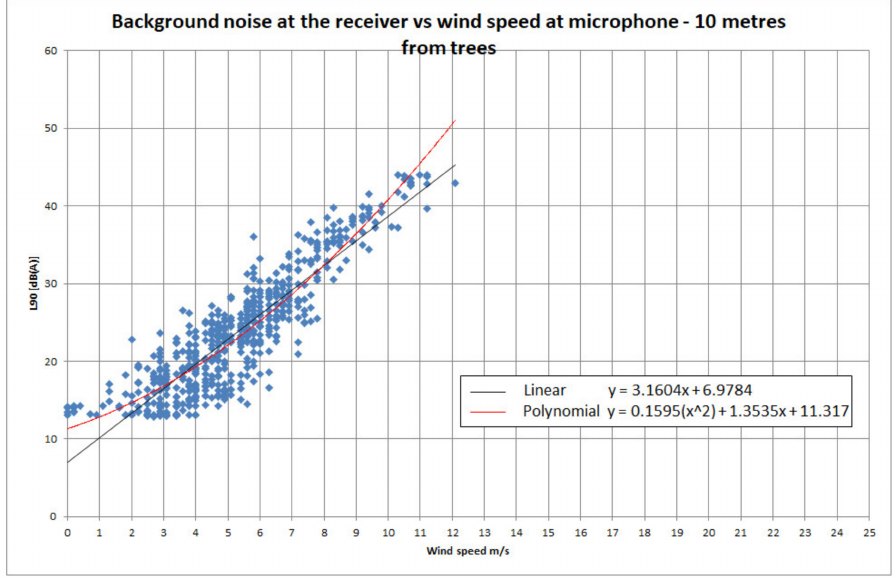
Figure 4. Synchronized background noise level versus wind speed at microphone for measurement location 10 metres from trees.